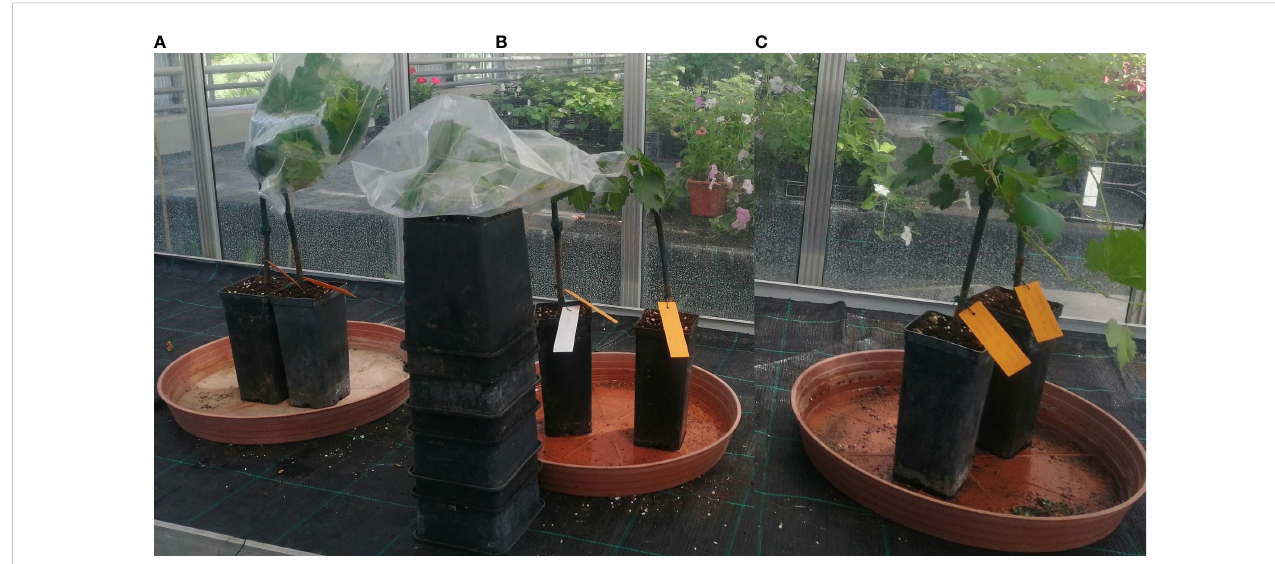
FIGURE 1 The arti fi cial inoculation of E. necator conidia onto a susceptible genotype using three different methods: (A) - dry dispersion of spores covered by a stapled funnel (left); (B) - spray of a conidial suspension covered with plastic (middle); (C) - spray of a conidial suspension air-dried